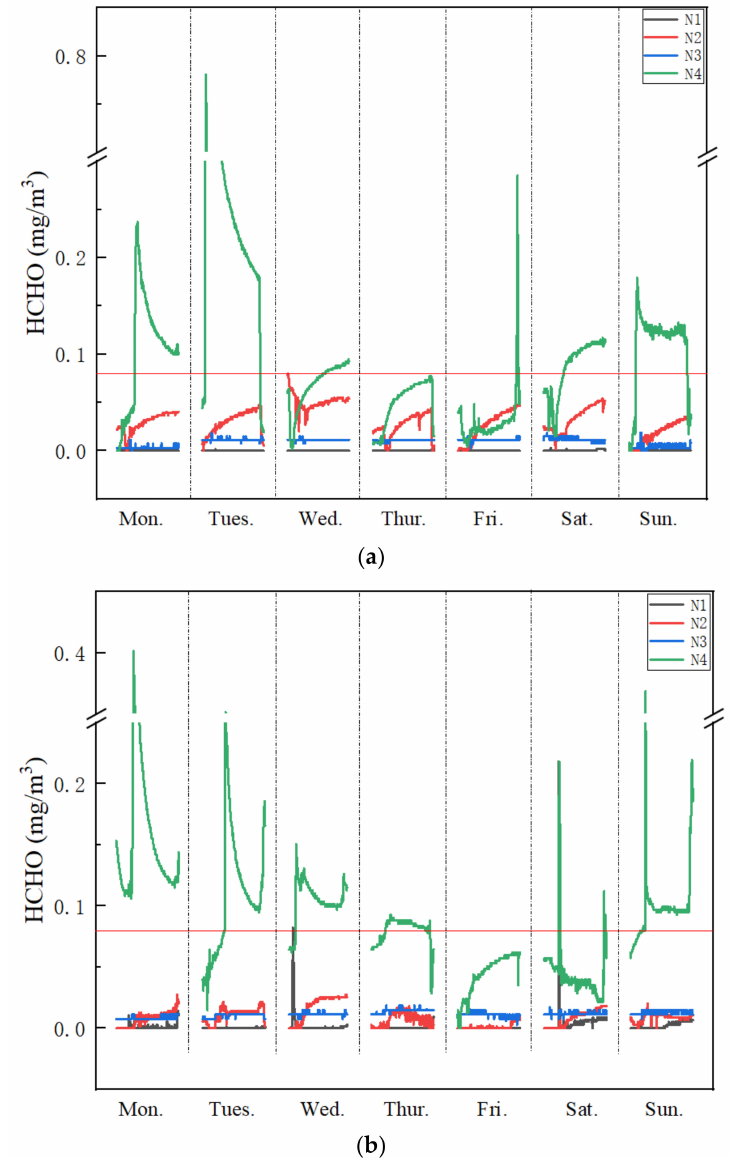
Figure 13. HCHO measurement results. ( a ) Before heating, ( b ) After